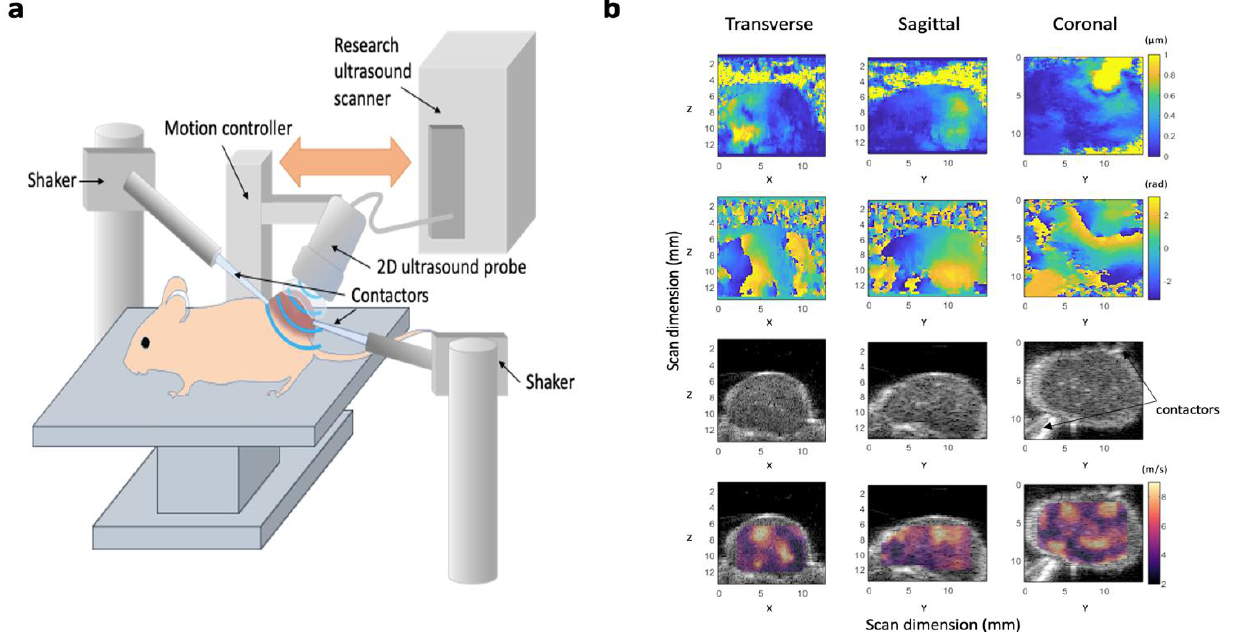
Figure 1. Design of our 3D-vibrational shear wave elastography (3D-VSWE) platform. ( a ) schematic showing the apparatus used to acquire vibrational shear wave elastography data. Two shakers were used as vibrational sources and were coupled to the tumours using carbon fibre rods and contactors. Shear wave fields were imaged using line-by-line focused imaging acquired with an L22-14vX linear array ultrasound probe and a Vantage system (both Verasonics Inc.). The probe was scanned superiorly in a step-and-shoot motion to collect 3D data. ( b ) Representative displacement amplitude maps (top row), phase maps (second row). B-mode image data (third row), and shear wave speed (c s ) maps overlayed on B-mode data (bottom row) acquired using a vibrational frequency of 1000 Hz. Images are the central slices of 3D datasets in the transverse, sagittal and coronal planes; numbers give the scan dimensions in millimetres in the Z (axial), X (lateral) and Z (elevational) directions. Two contactors can be seen in the B-mode images, however, these data were acquired with only one vibrational source